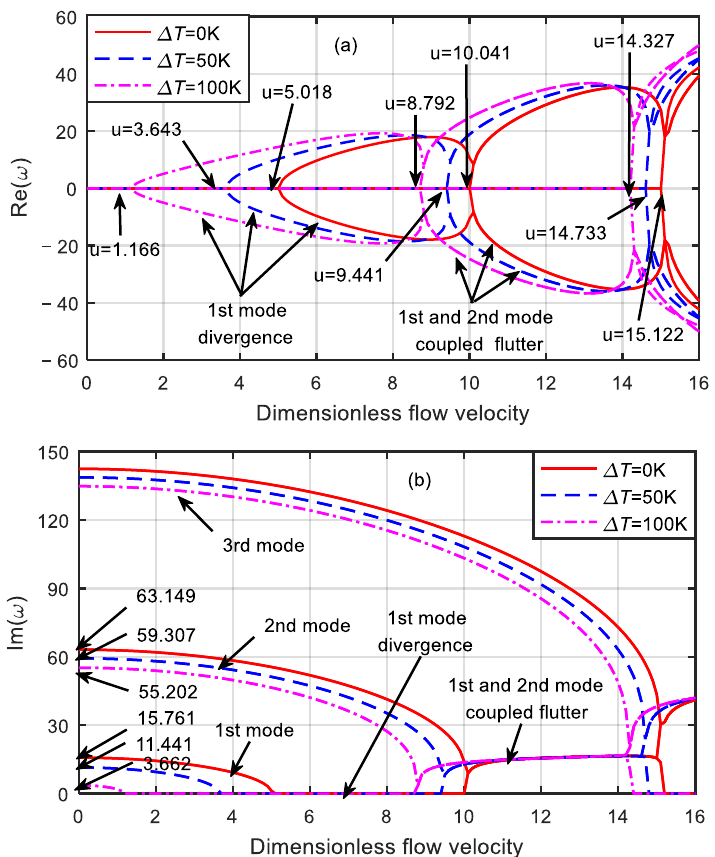
Figure 4. Dimensionless eigenfrequency variations with dimensionless flow velocity for various temperature differences ( δ = 3). ( a ) Real part. ( b ) Imaginary part.